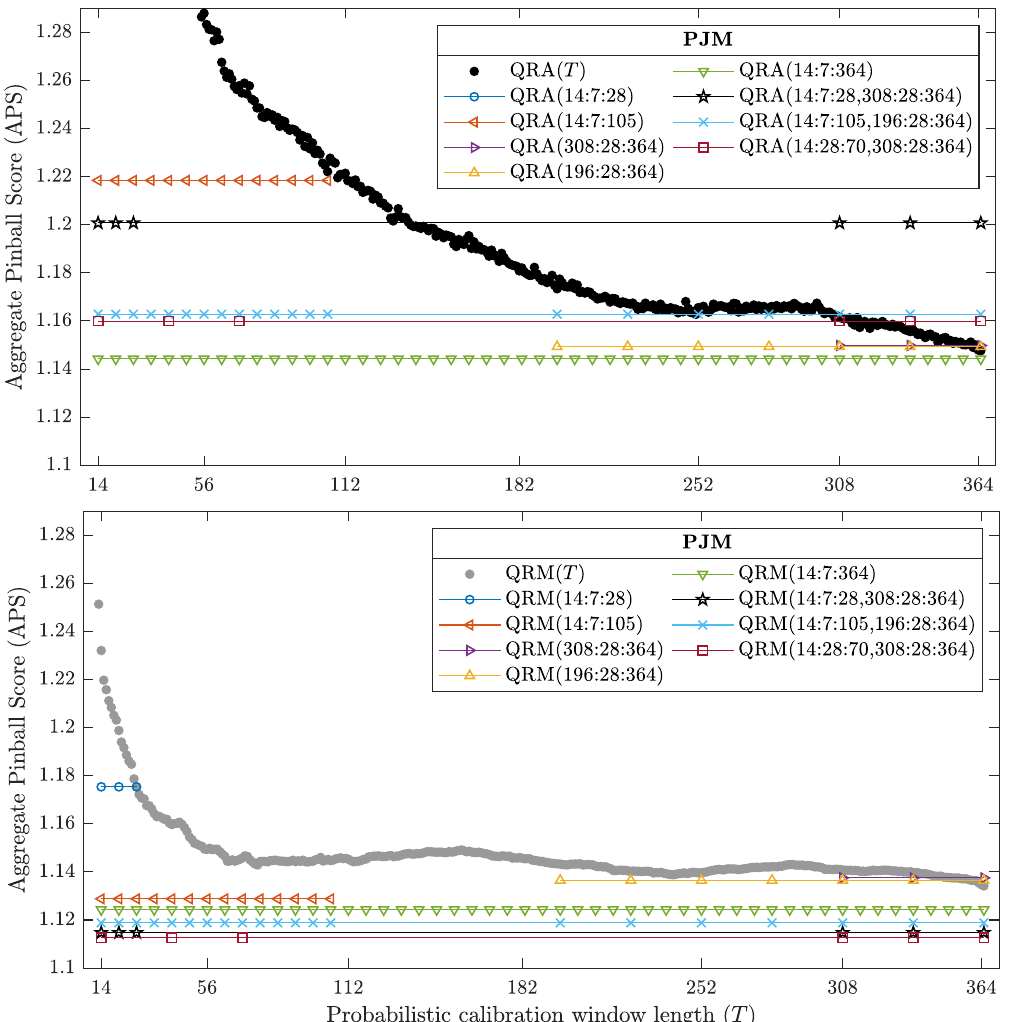
Figure 6. Aggregate pinball scores (APS) for probabilistic QRA ( top ) and QRM ( bottom ) forecasts for the PJM dataset. Filled circles refer to individual probabilistic calibration window lengths and lines with symbols indicate window lengths selected for averaging